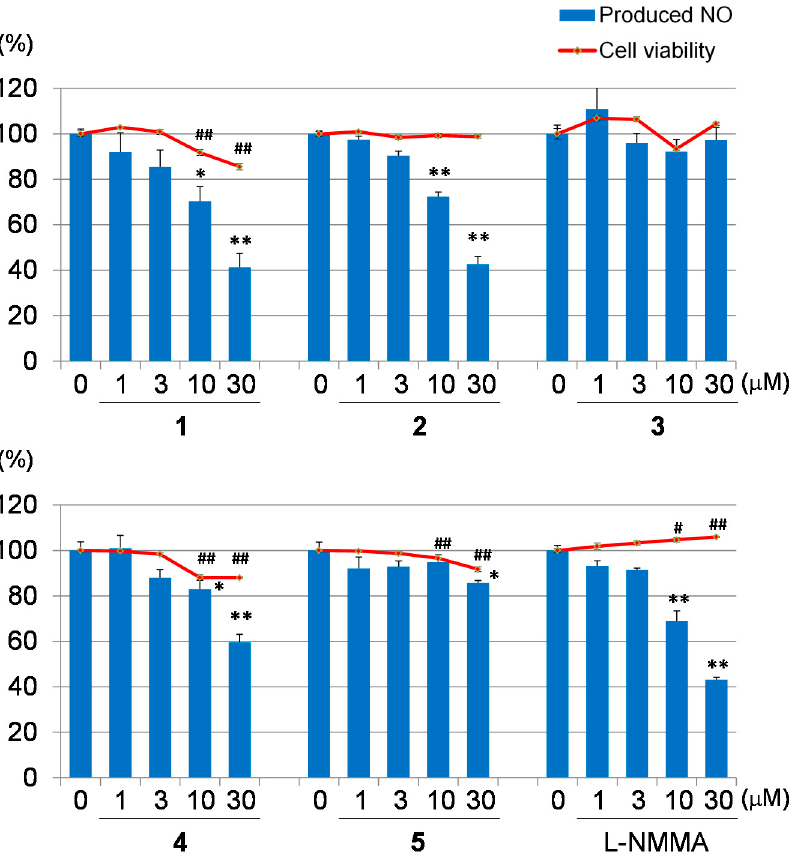
Figure 5. Inhibitory activities on NO production and cytotoxicities of Compounds 1 – 5 and L -NMMA. Each value represents the mean ± the standard error (S.E.) of four determinations. Significant differences from the vehicle control (0 μ M) group shown as * p < 0.05 and ** p < 0.01 in the NO inhibitory assay and # p < 0.05 and ## p < 0.01 in the cytotoxicity assay.